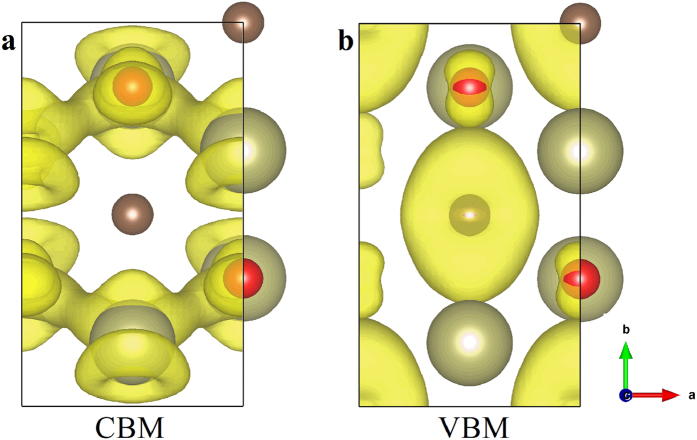
The electronic wavefunctions of the CBM and VBM for Hf2CO2 based on the orthorhombic cell.(a) CBM. (b) VBM.